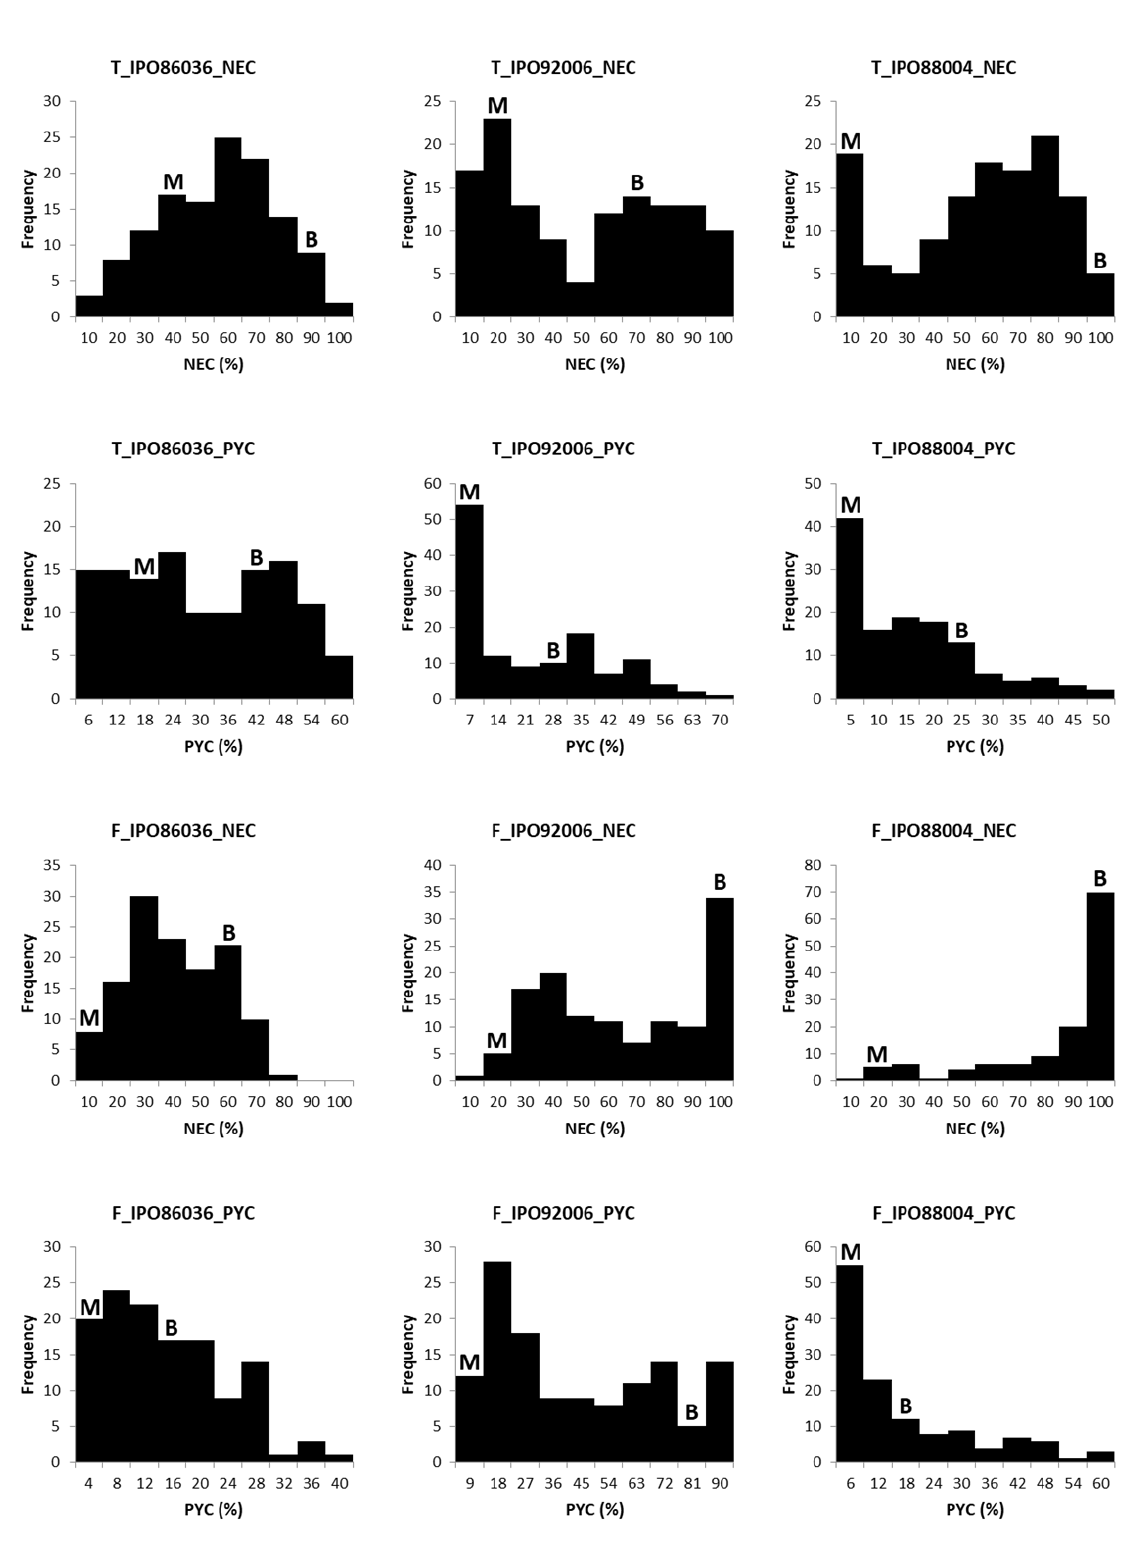
Figure 1. Frequency distributions of disease parameters in the Mandub × Begra DH population. The data set designation is shown in the upper-left corner of each histogram. Data set name consists of the following designations: T—polytunnel or F—plant growth chamber; isolate name IPO86036, IPO92006 or IPO88004, respectively; percentage of leaf area covered with necrosis (NEC) or pycnidia (PYC). The average values for parental lines are indicated by letters: M (Mandub) and B (Begra).